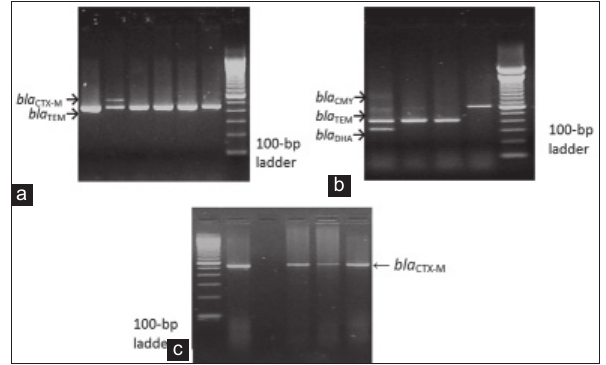
Figure-1: (a) The result of the multiplex polymerase chain reaction (PCR) amplification of the DNA target gene loci of 593-bp fragment DNA region coding for CTX-M; 431-bp fragment DNA region coding for TEM, (b) the result of the multiplex PCR amplification of the DNA target gene loci of: 695-bp fragment DNA region coding for CMY-2; 431- bp fragment DNA region coding for TEM; 314-bp fragment DNA region coding for DHA, (c) the result of the multiplex PCR amplification of the DNA target gene loci of 593-bp fragment DNA region coding for